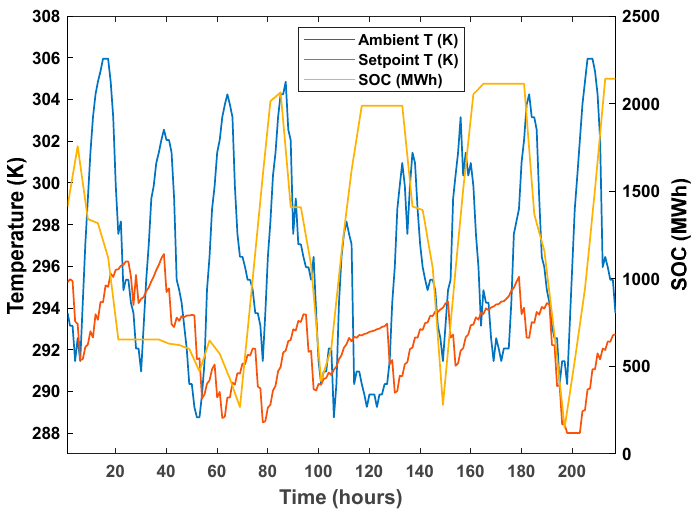
Figure 13. Some of the variables of the input dynamic model.